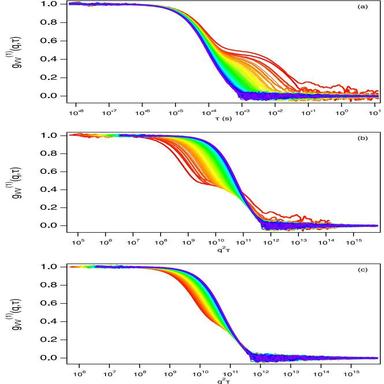
(a) VV EACFs from 12◦ to 140◦ in 2◦ steps, angles increase from red to blue. (b) The same data plotted vs. q2τ. (c) The same data, but with curves that do not collapse at the second decay removed. Data that remains is from θ = 38◦ to 140◦. The curves which collapse at the second decay indicate translation diffusion, and thus Dt can be extracted from a double exponential fit to the data. Data for gold nanorods of nominal dimensions L = 118 nm, D = 40 nm. After . (For interpretation of the references to colo